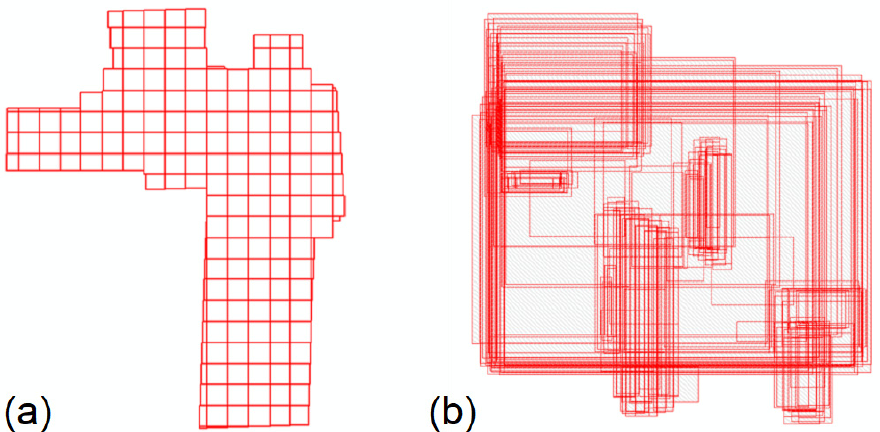
Figure 4. ( a ) A typical LAS dataset after undergoing standard post-processing; ( b ) the LAS dataset produced from each of the S1, S2, and S3 groups of LAS files provided from CHS.